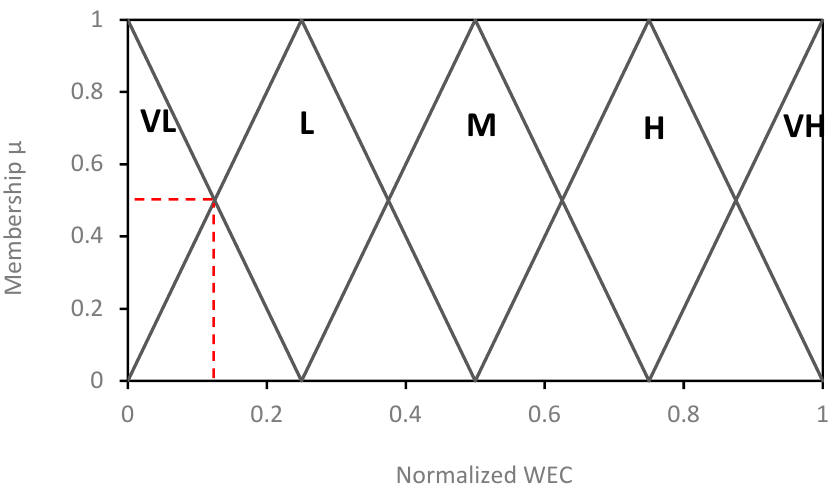
Figure 2. Fuzzification and fuzzy memberships.